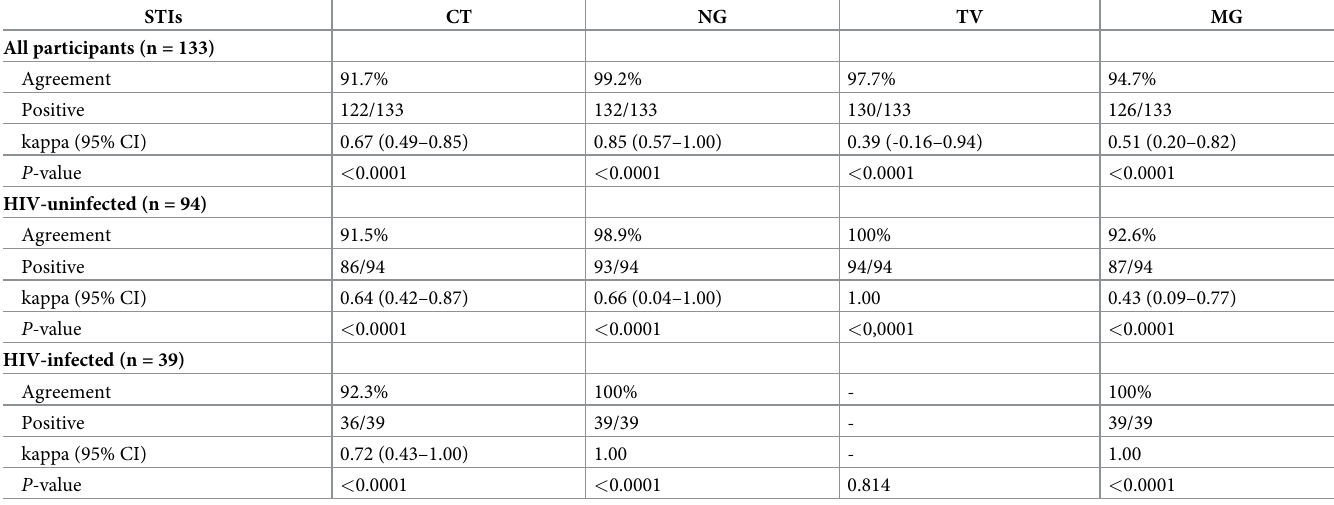
Table 3. Concordance between cervico-vaginal self-collection and cervical scraping collection calculated using the Kappa test. STIs CT NG TV MG All participants (n =